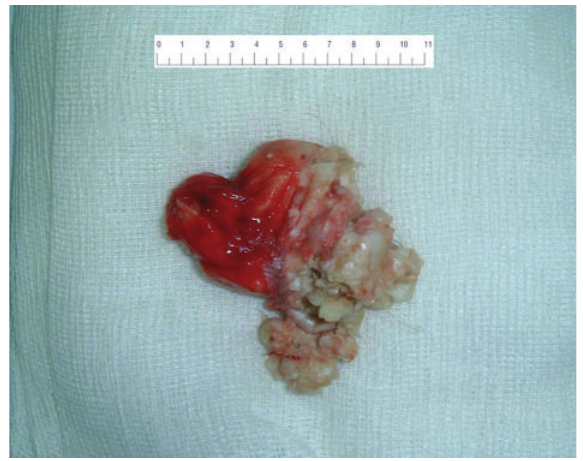
Figure 5: The macroscopic image of the surgical l extract with clear evidence of cystic formation (6,5 cm) containing smegma and hairs, indicative of a dermoid cyst.